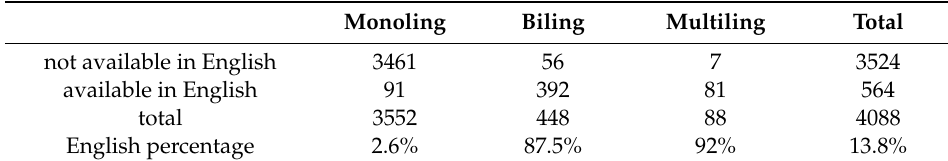
Table A52. English language availability (es).